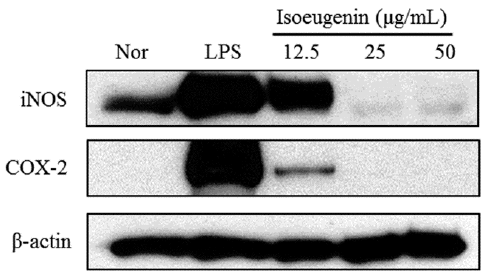
Figure 3. Inhibitory effects of isoeugenin on LPS-induced iNOS and COX-2 protein expressions in RAW264.7 cells. Cells were pretreated with different concentrations (12.5, 25, 50 µ g/mL) of isoeugenin